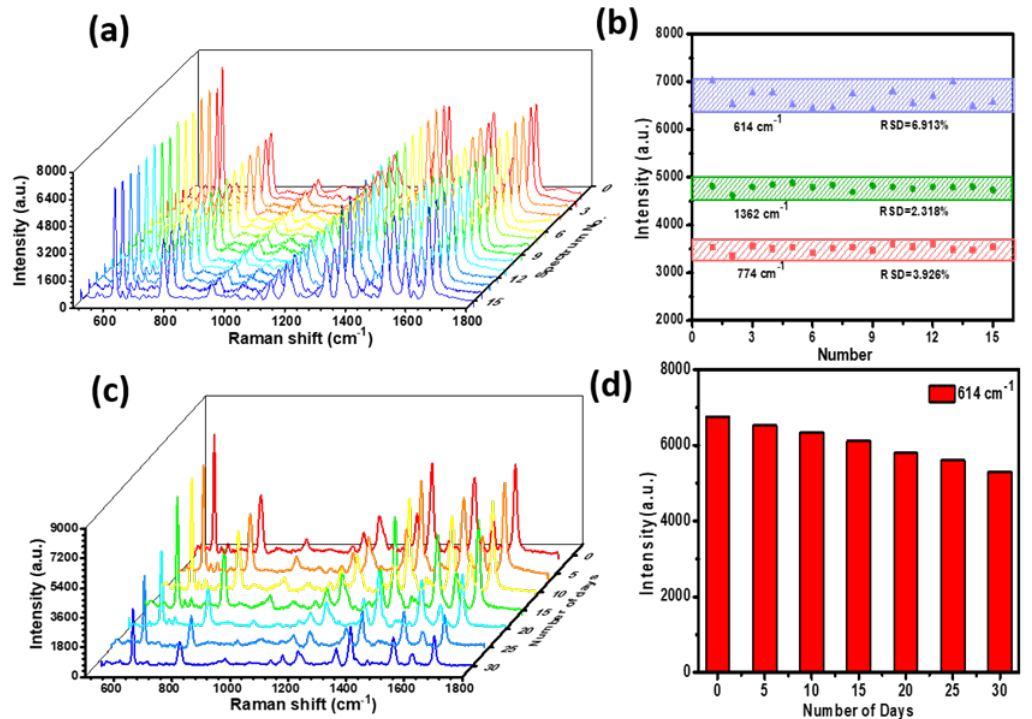
Figure 5 . ( a ) Raman spectra collected from different points on the P–AgNPs@PMMA substrate